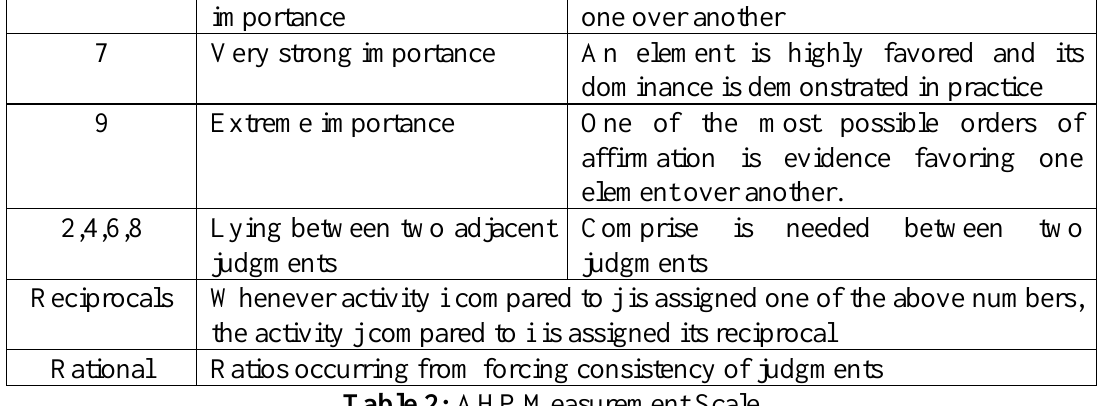
Table 2: AHP Measurement Scale